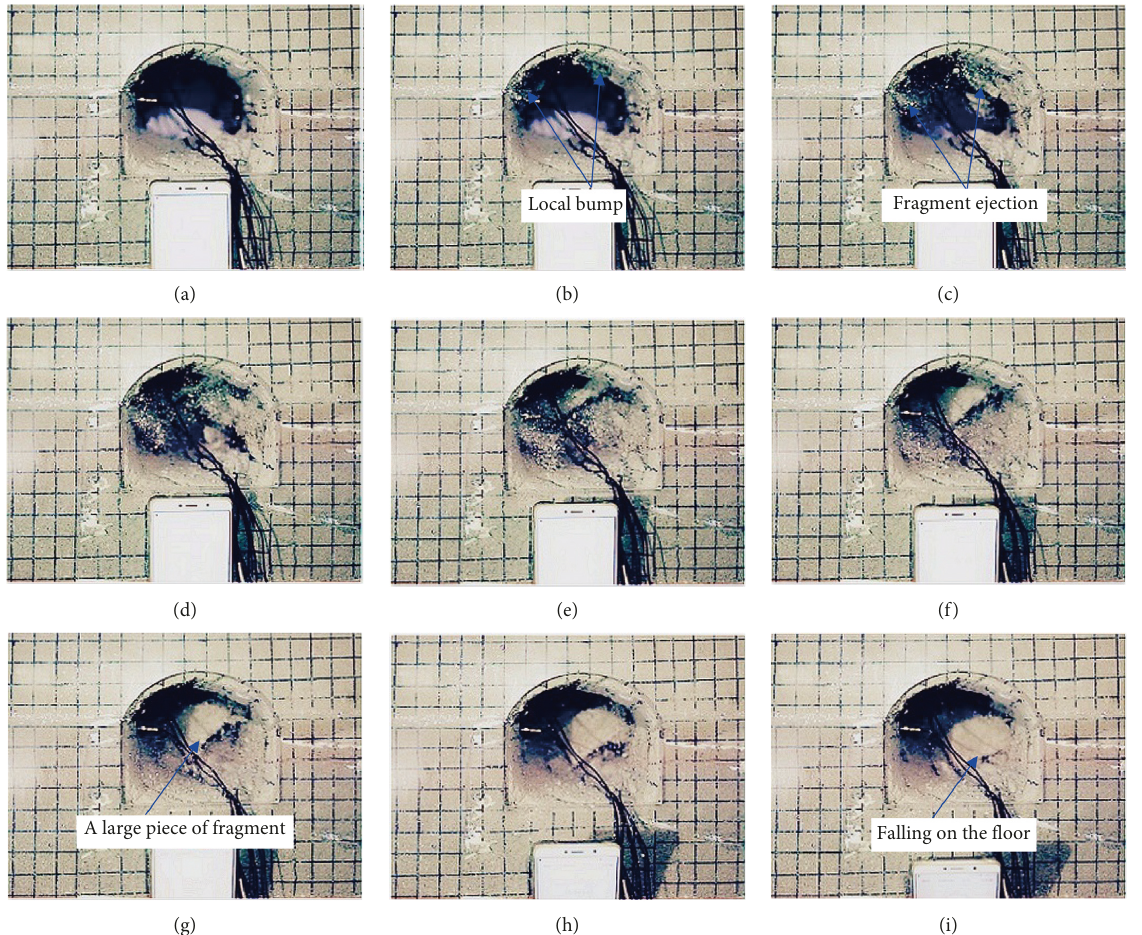
Figure 9: Bursting failure patterns of the modeled roadway recorded with the high-speed camera. (a) 0 ms, (b) 22ms, (c) 44ms, (d) 66ms, (e) 88ms, (f) 110ms, (g) 132ms, (h) 154ms, and (i)